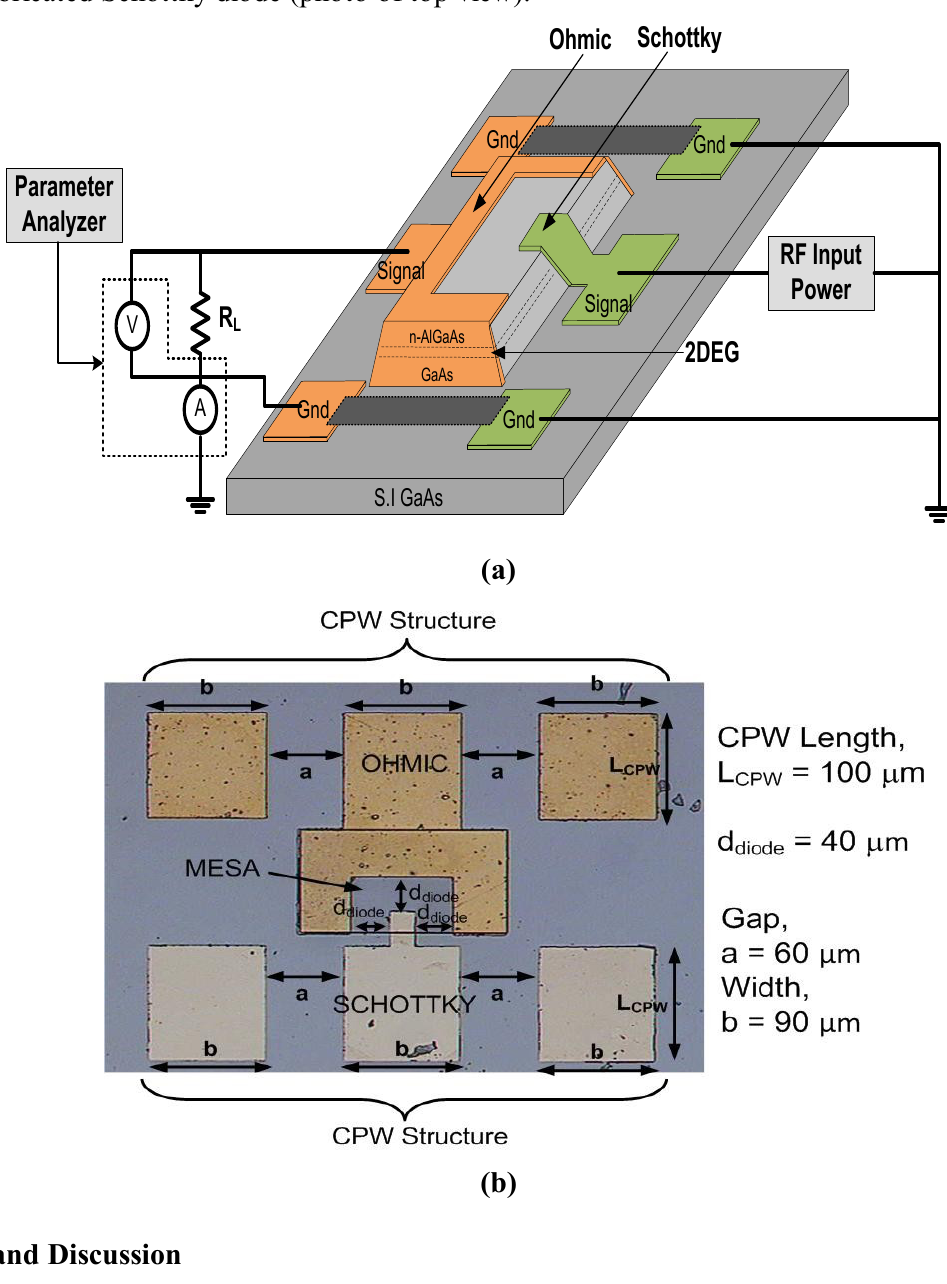
Figure 1. (a) Schematic of device structure (including measurement circuit) and (b) fabricated Schottky diode (photo of top